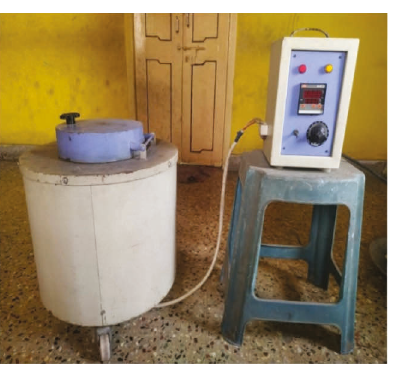
Figure 1: Stir casting